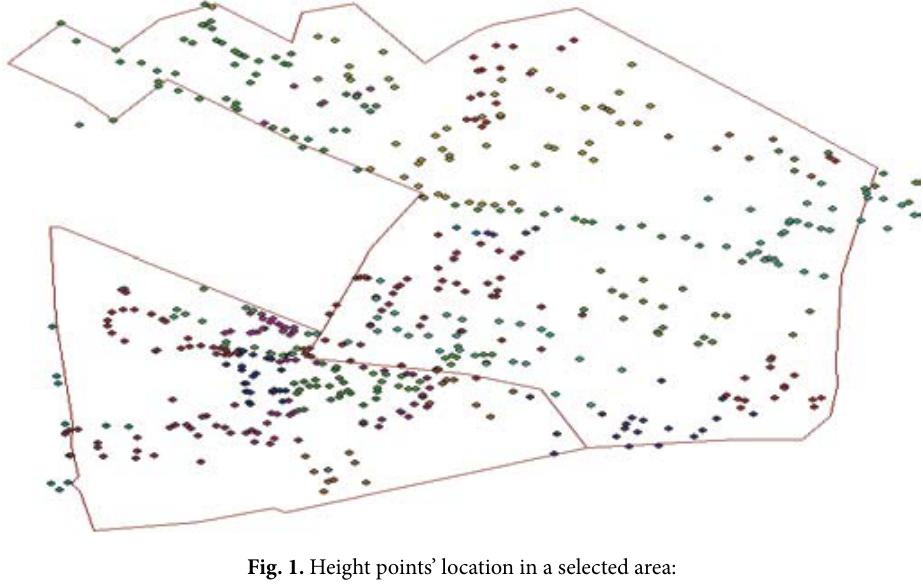
Fig. 1. Height points’ location in a selected area: ♦ – points obtained by geodetic measurements ; — – boundary of garden